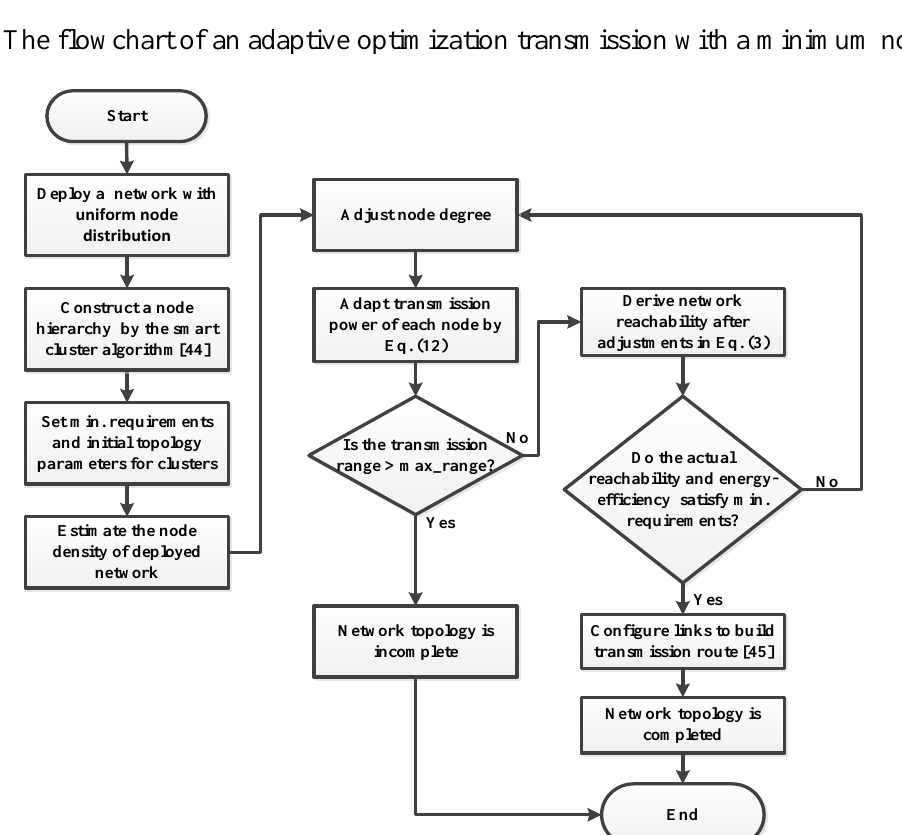
Figure 3. The flowchart of an adaptive optimization transmission with a minimum node degree.